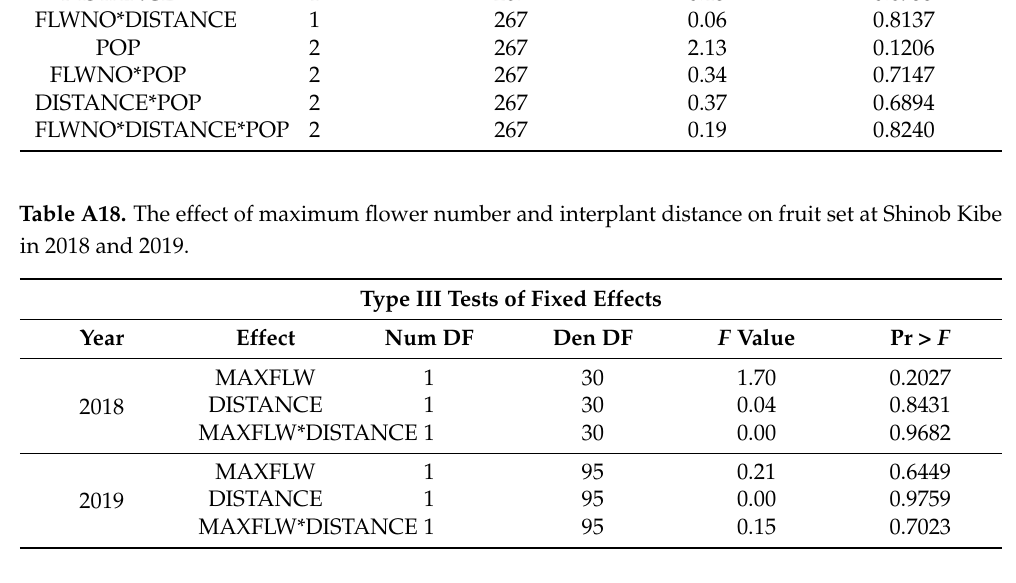
Table A19. The effect of maximum flower number and interplant distance on fertilization success across three populations in 2019 and for these three populations analyzed